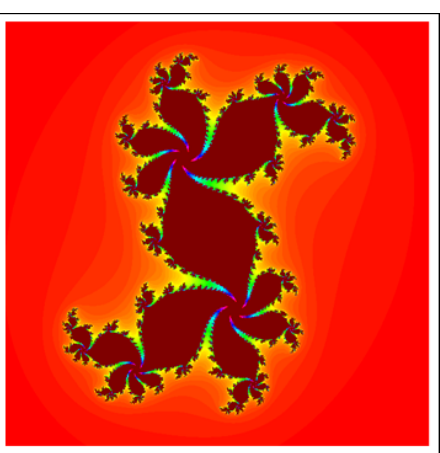
Figure 1. Second degree J-set via F-iteration with visualization period = 76.6 s.